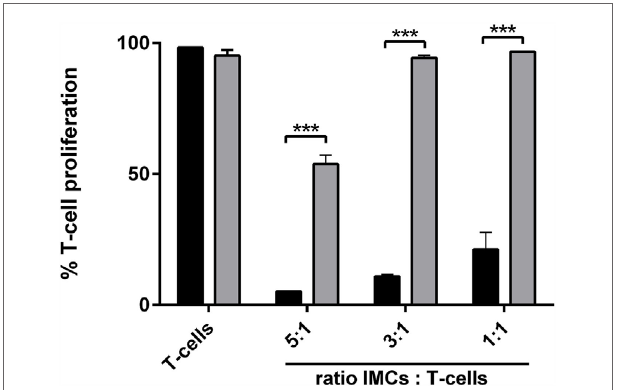
FigUre 6 | incubation with licofelone reduces suppressive activity of gr-1 + cD11b + iMcs . BM cells differentiated in the presence of GM-CSF (20 ng/mL) and PGE 2 (9.1 μ g/mL) were incubated with licofelone (5 μ M) for 20 h (gray bar) or media (black bar) and then pulsed with LPS and OVA 257–264 for 4 h before they were cocultured with CFSE-stained splenocytes from OT-I mice in varying ratios. After 72 h, the proliferation of OVA stimulated T-cells was assessed by flow cytometry. Data are representative of three independent experiments with two replicates + SD each, *** p < 0.0001.